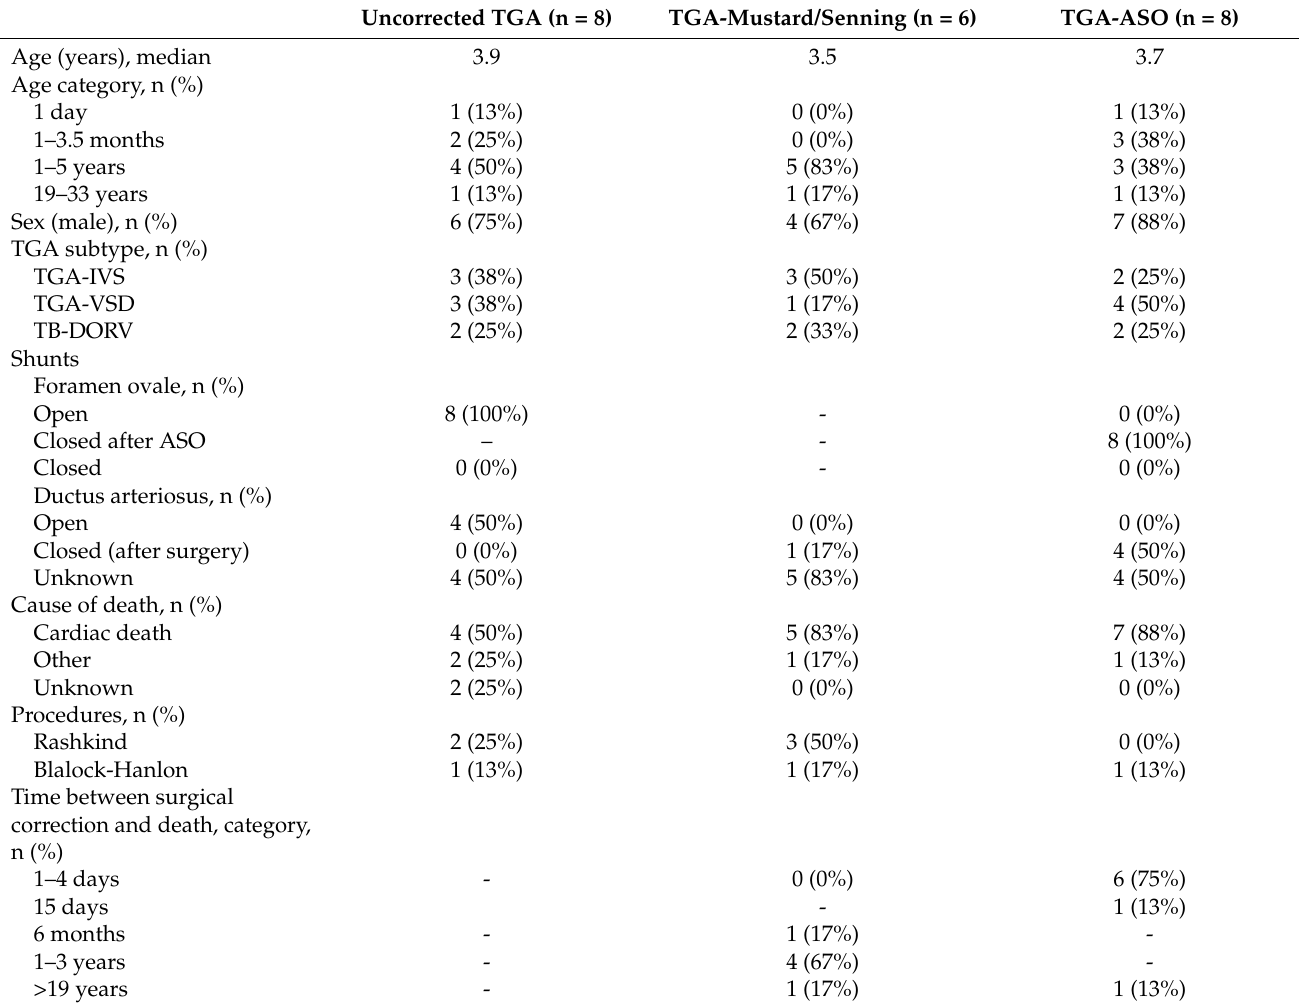
Table 1. Characteristics of the postmortem